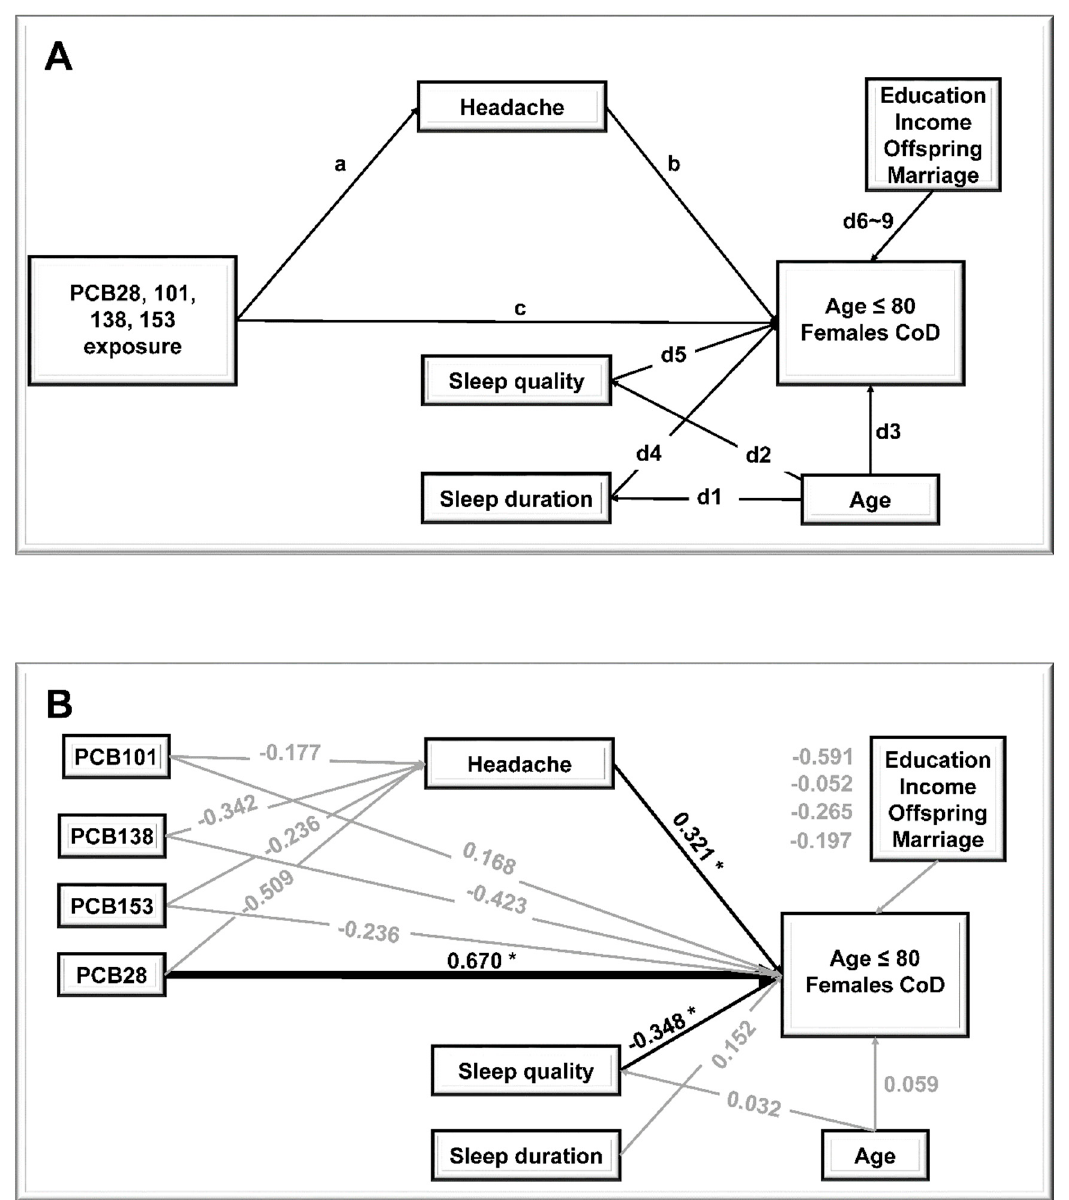
Figure 1. Process of path analysis by structural equation modeling (SEM). ( A ) The hypothesis model of the exposure of 4 PCBs (PCB 28, PCB 101, PCB 138, and PCB 153), female participants’ CoD and confounders; ( B ) the direct effect of exposure to PCB 28 on CoD in female participants with ages below and equal to 80. * and blank line indicate p value < 0.05. The gray line indicates p value ≥ 0.05. Line thickness represents effect size (the thicker the line, the stronger the effect’s absolute